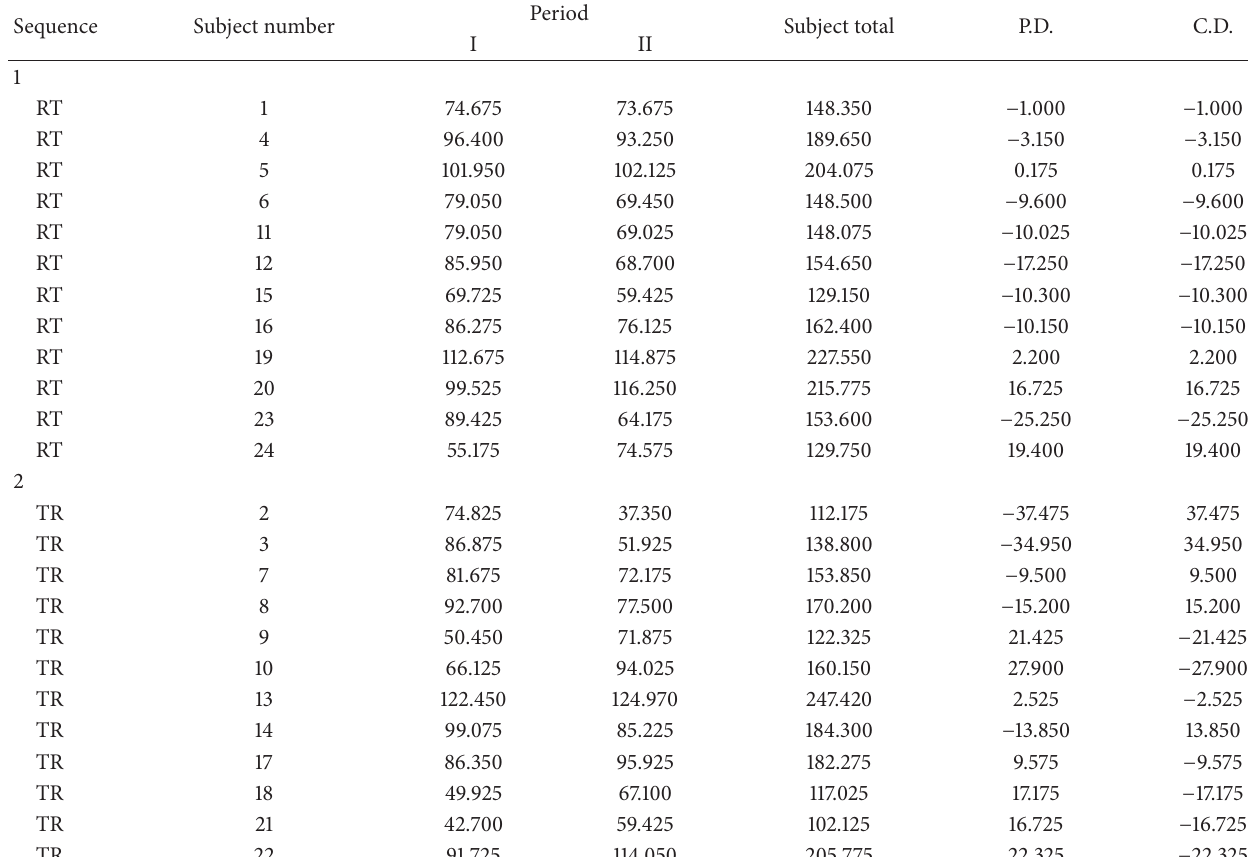
Table 1: Data of the crossover trial.